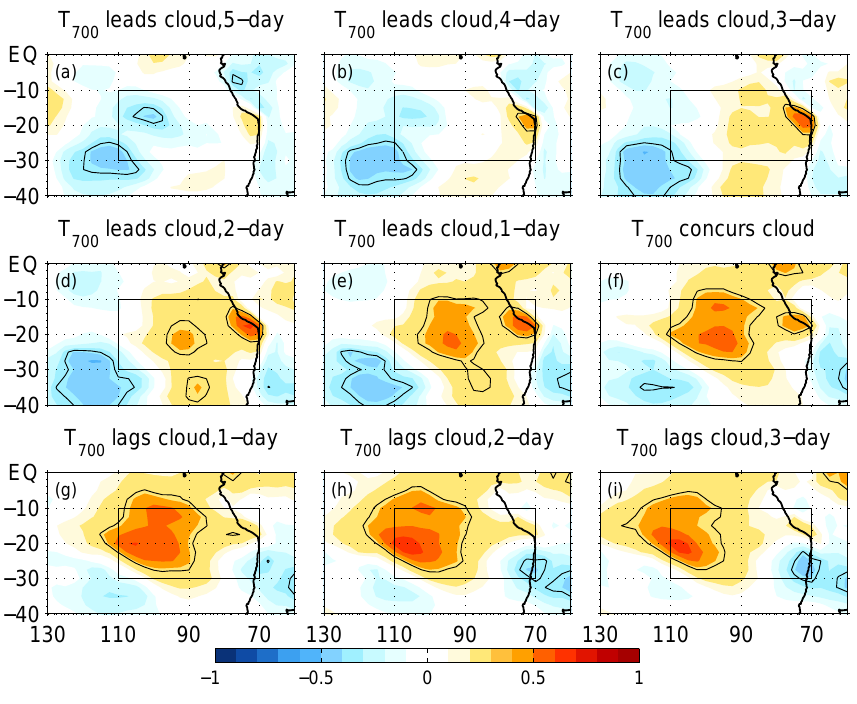
Fig. 10. Lead-lag correlation of daily area-averaged adjusted low cloud amount with daily temperature at 700hPa at each grid point for austral summer (DJF) of 2000. Contour line denoting the 95% significance level using the Student-t test is highlighted.